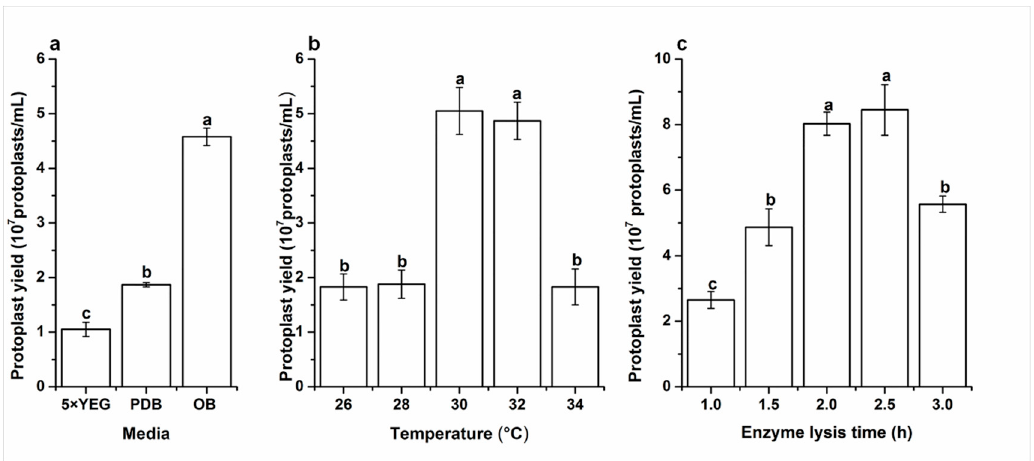
Figure 1. ( a ) Effects of media on protoplast yield; ( b ) effects of digesting temperature on protoplast yield; and ( c ) effects of enzyme lysis time on protoplast yield. Data represent the mean ± standard errors (SE) of three independent experiments. Different lower-case letters indicate a significant difference ( p < 0.05).